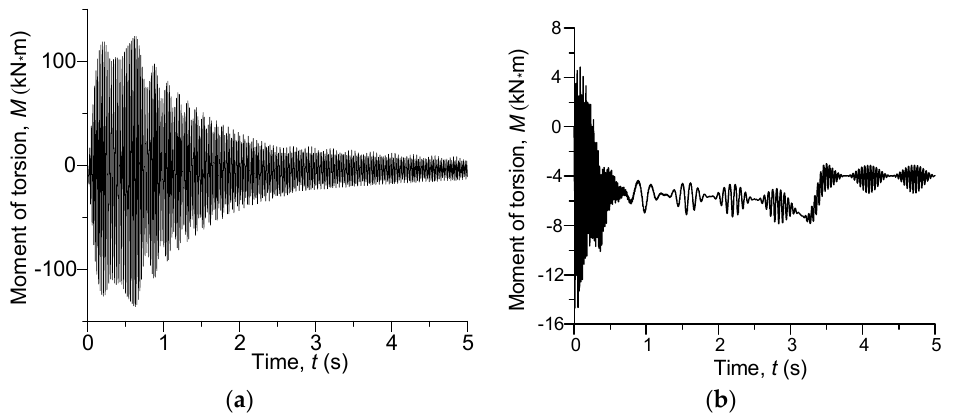
Figure 11. Moments of torsion in the middle of the shaft for: ( a ) D = 0.1825 m; α 1,2 = α 2,3 = π /5, ( b ) D